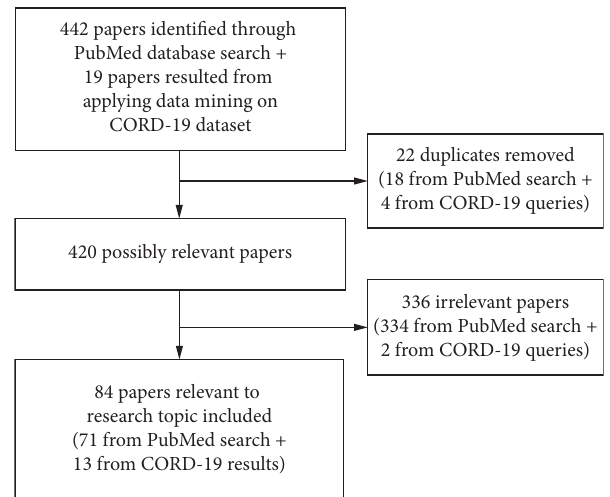
Figure 1: Study selection process and number of papers included.